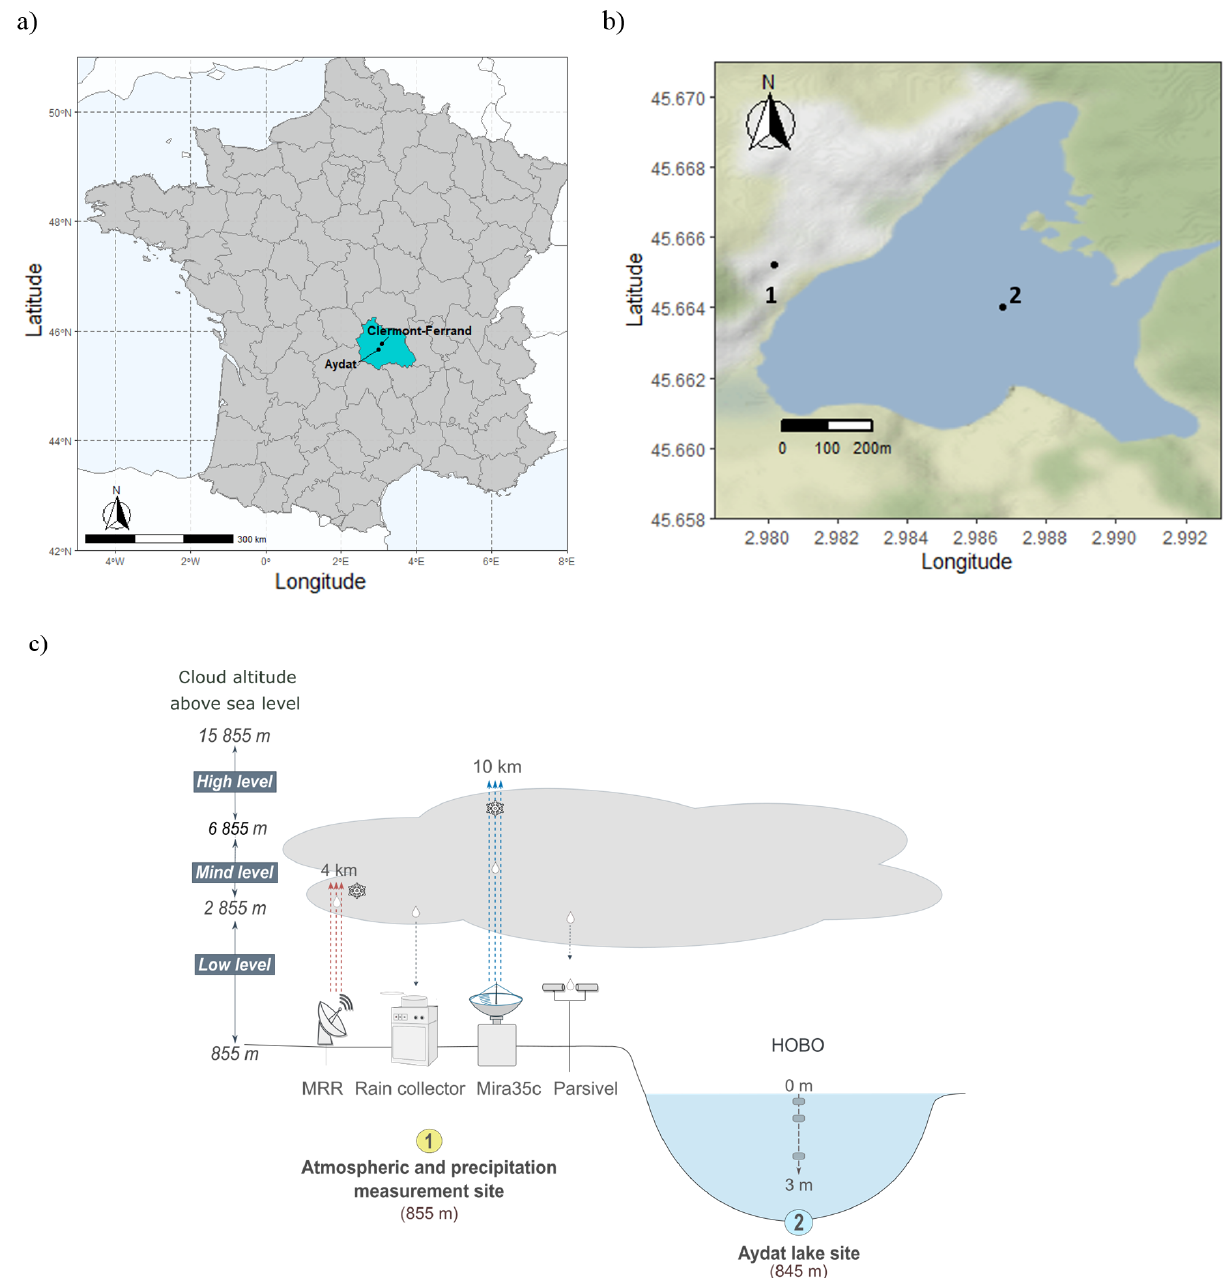
Figure 1. (a) Location of the town of Aydat, a commune in the Puy-de-Dôme department in Auvergne-Rhône-Alpes in central France. (b) Map of Lake Aydat showing the location of the instrumental setup which comprises (1) the atmospheric and precipitation measurement site and (2) the Lake Aydat site. (c) Conceptual diagram of the overall Aydat instrumental setup. OpenStreetMap data are available under the Open Database license (https://opendatacommons.org/licenses/odbl/, last access: 12 December 2022). Maps are released under the Creative Commons Attribution-ShareAlike 2.0 (CC-BY-SA 2.0) license (https://creativecommons.org/licenses/by-sa/2.0/, last access: 12 December